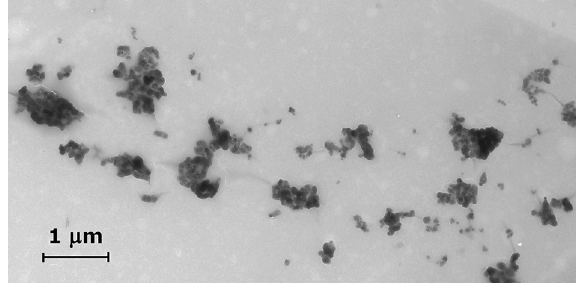
Fig. 3 TEM image of aerosol aggregates sampled in coal